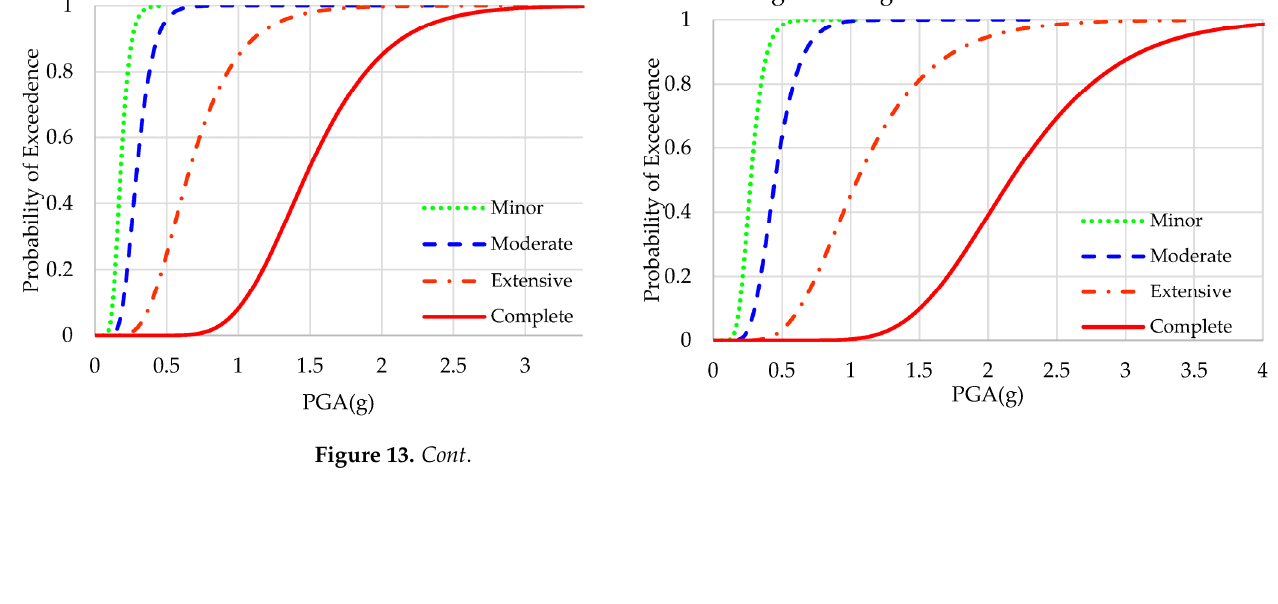
Figure 12. Fragility curves of the original and GFRP flange ‐ bonding frames in each state.